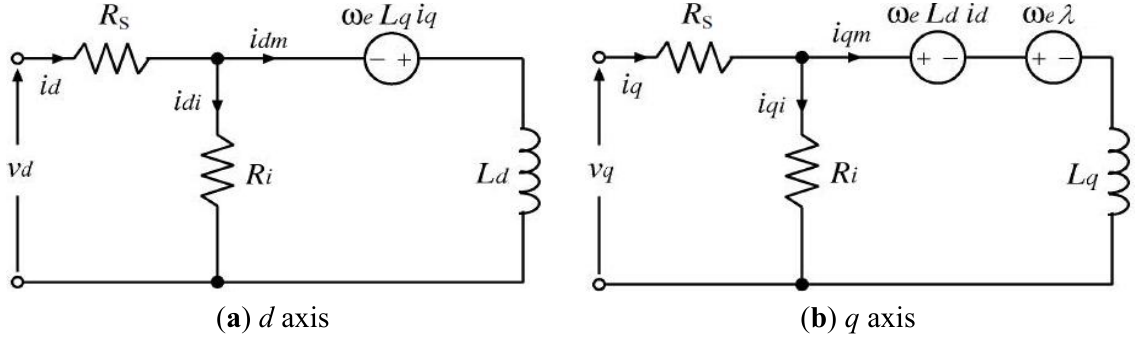
Figure 4. PMG d ( a ) and q ( b ) axes equivalent circuits.